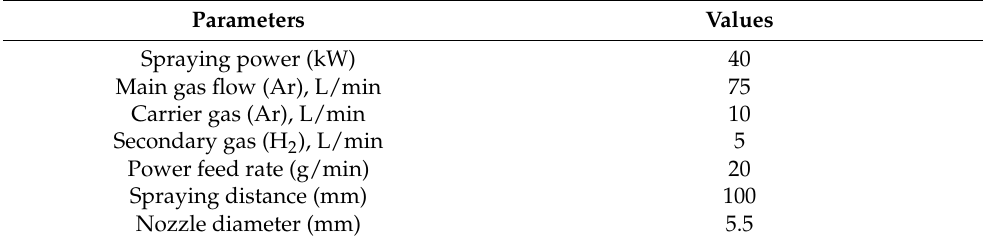
Table 1. Spraying parameters of the ZrSi 2 -SiC coatings prepared by SAPS. Parameters